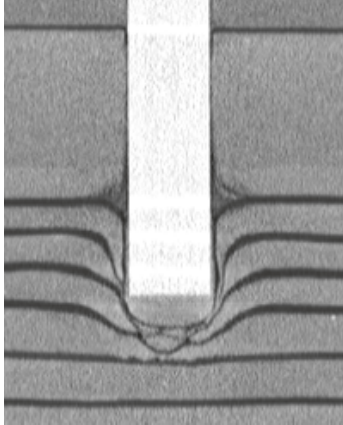
Figure 10: Pile tip failure model (settlement/diameter = 1.7).